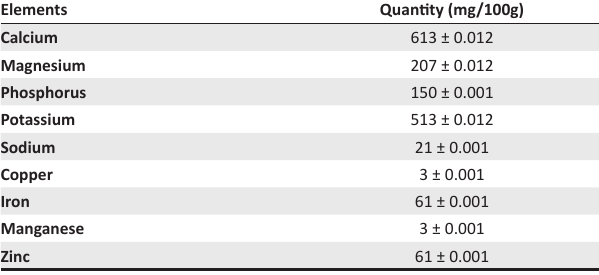
TABLE 3: Mineral composition of Crescentia cujete leaves on dry basis.